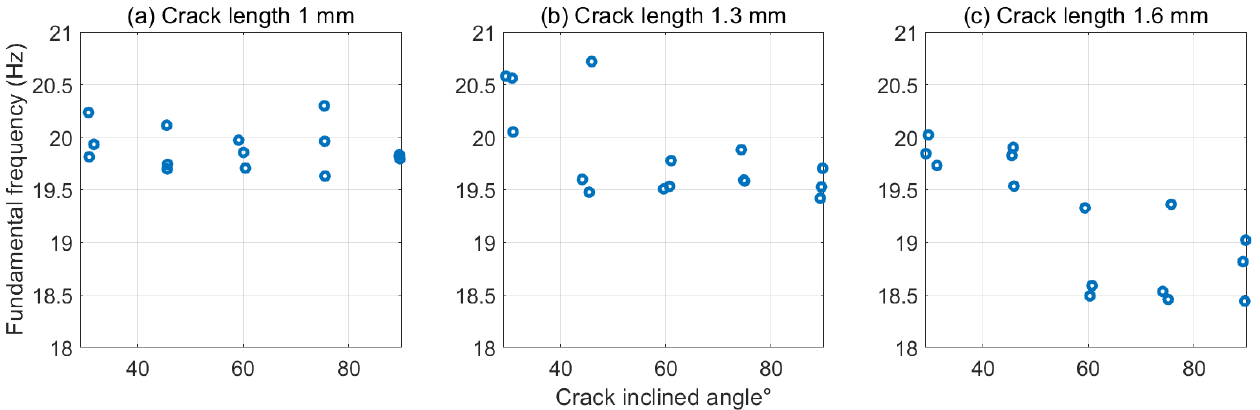
Figure 8. Fundamental frequencies for inclined cracks with different angles. ( a ) 1 mm crack length. ( b ) 1.3 mm crack length. ( c ) 1.6 mm crack